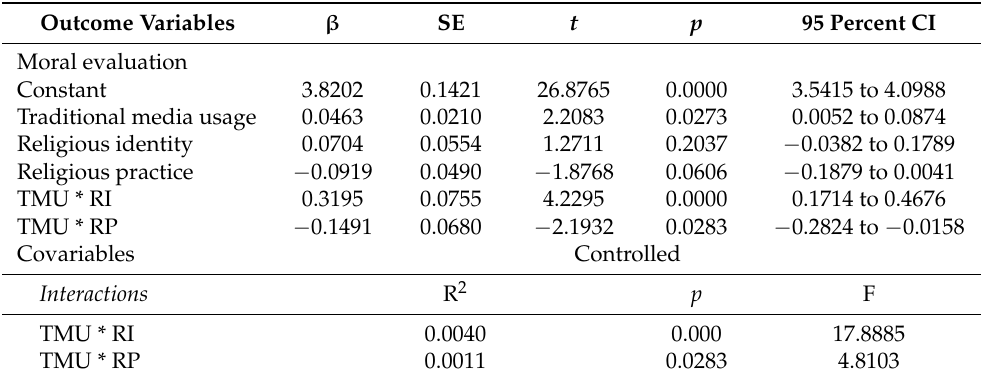
Table 3. The results of testing religious identity and religious practice as moderators between traditional media usage and moral evaluation.